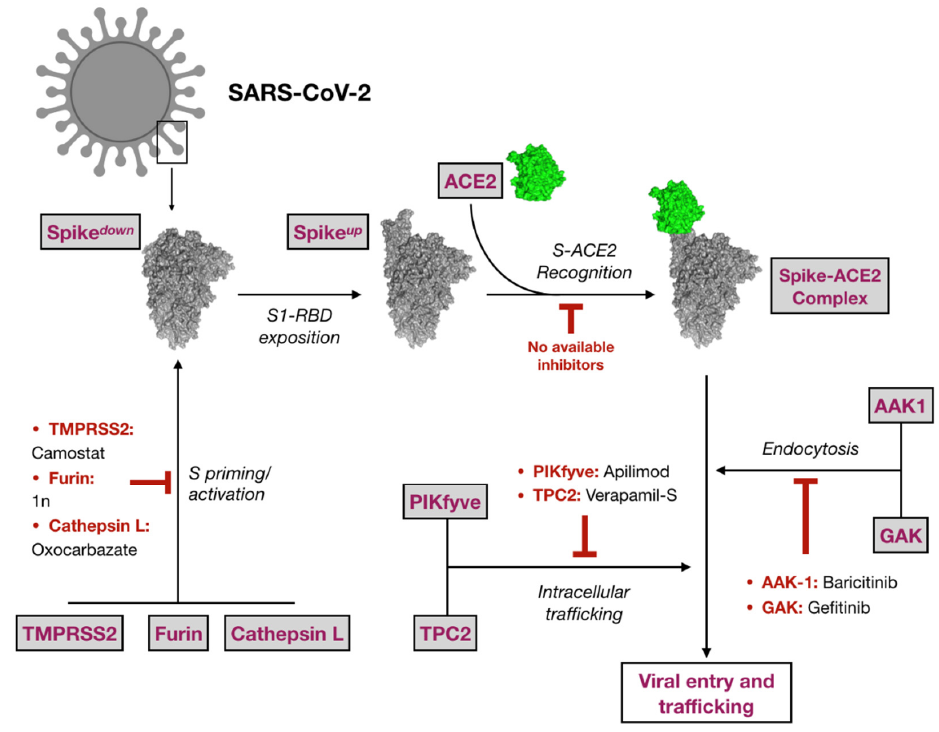
Figure 1. Schematic representation of the eight targets selected in this study and their role in virus entry. Representative inhibitors are also cited, when available.